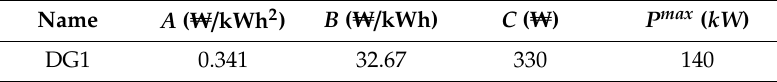
Table 2. Coefficients of the cost function and output range of DG.